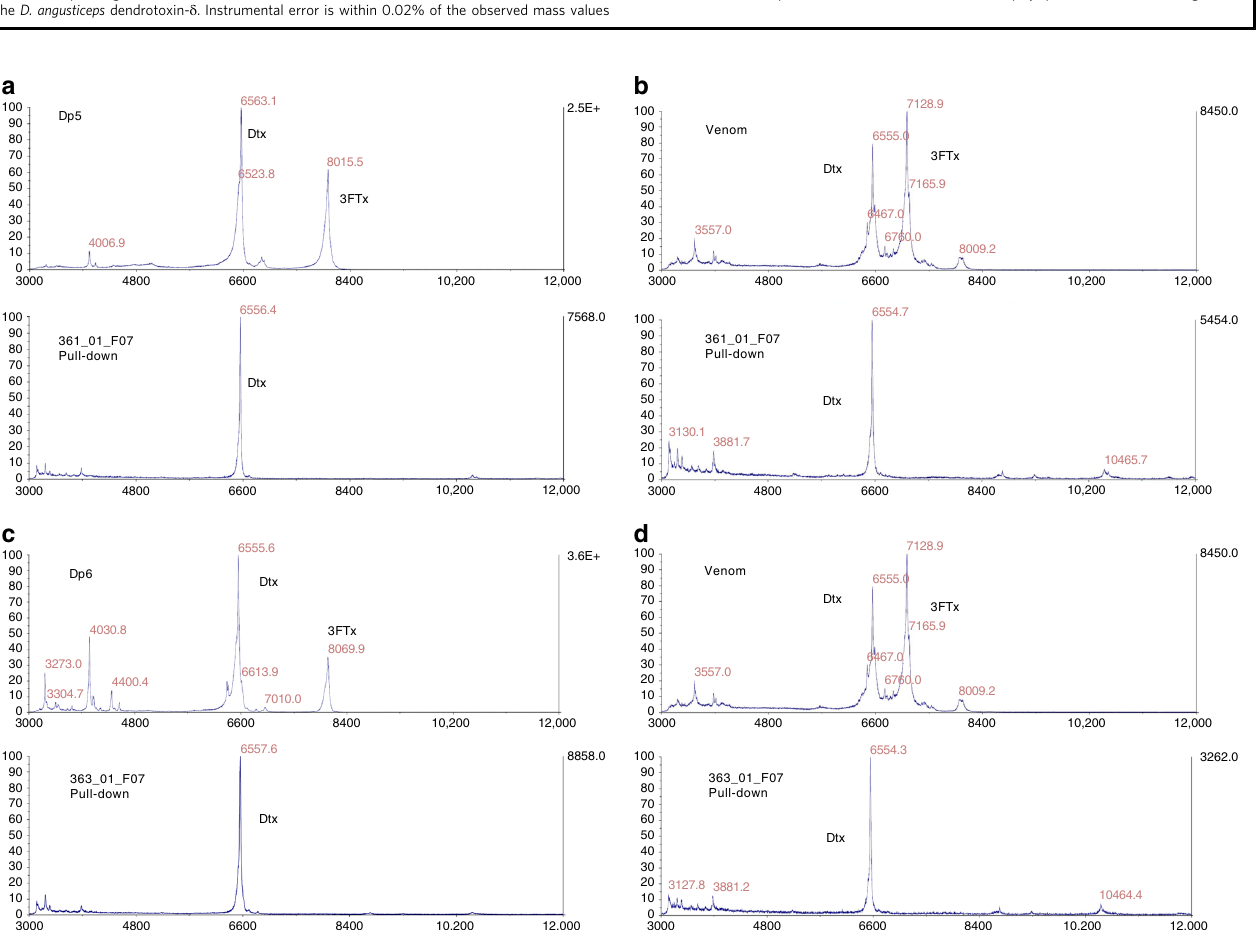
Table 1 Overview of all MALDI-TOF MS pull-down experiments IgG Antigen Mass(es) detected (venom fraction) (M + H)